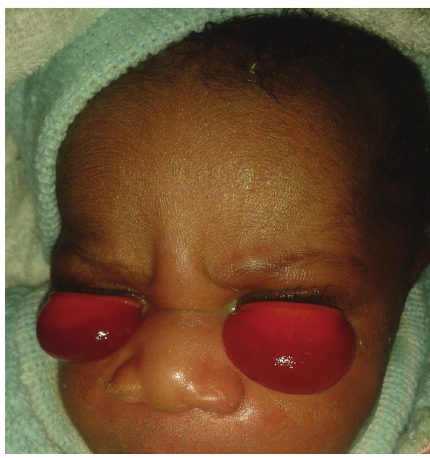
Figure 1: Six-hour-old newborn with upper eyelids everted and severe chemosis.